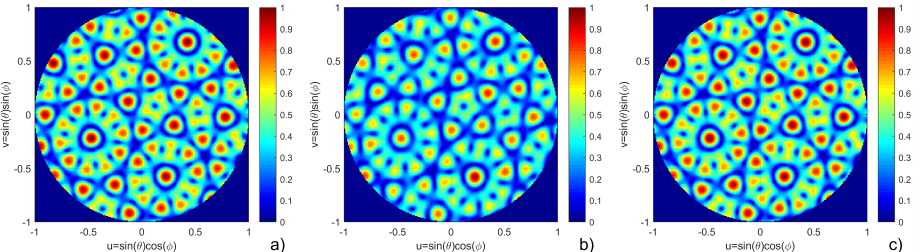
Figure 5. Comparison of far-field reconstruction with the two algorithms. Subplot ( a ) “true” field; subplot ( b ) “standard” algorithm; subplot ( c ): “smooth” algorithm. To simplify the comparison, all the fields are normalized with respect to the maximum amplitude of the “true”